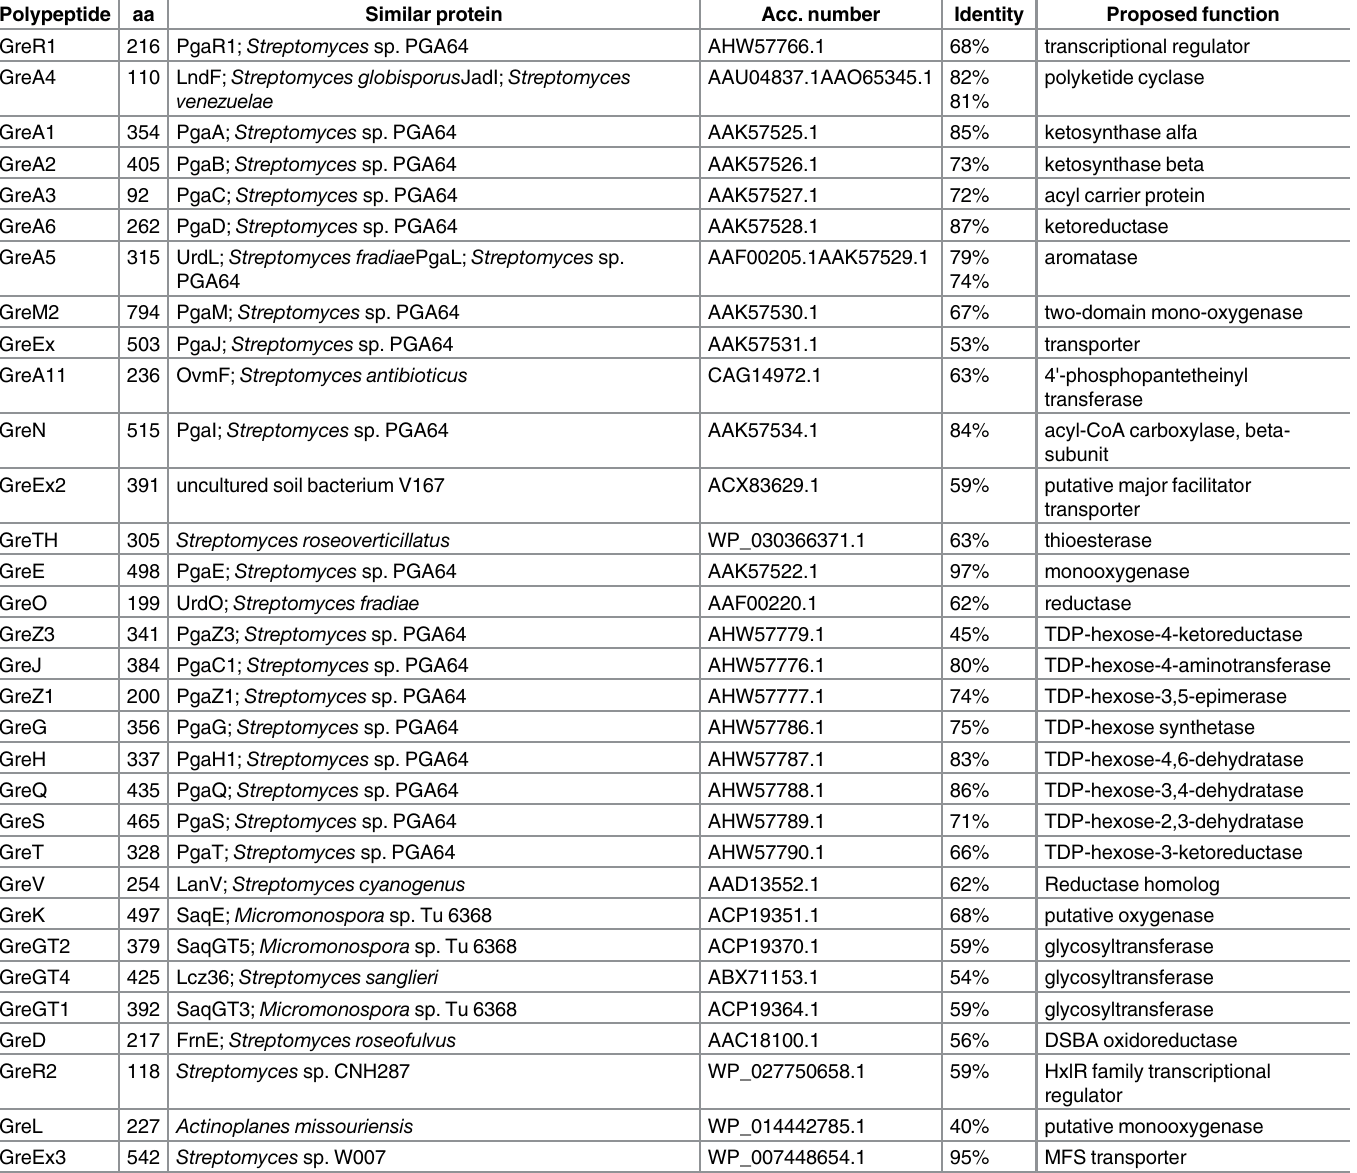
Table 1. Deduced function of ORFs in the grecocycline biosynthetic gene cluster. Polypeptide aa Similar protein Acc.